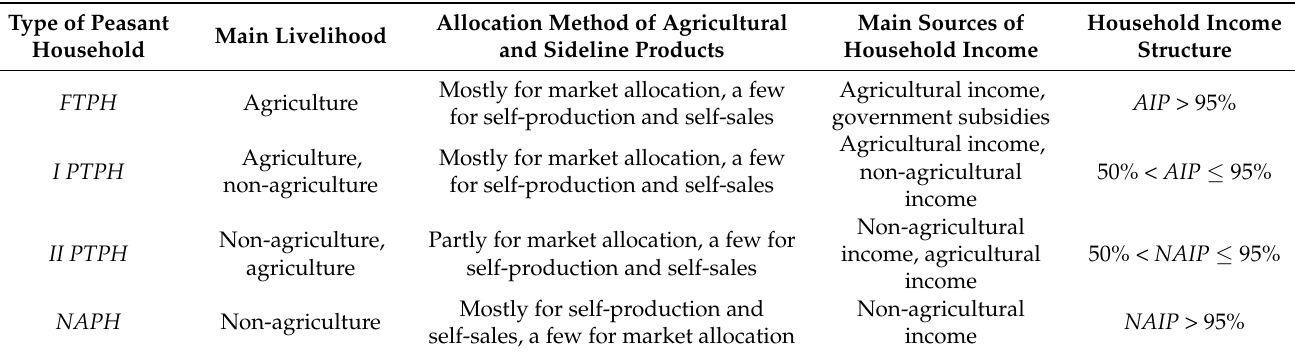
Table 1. Criteria for classifying peasant household